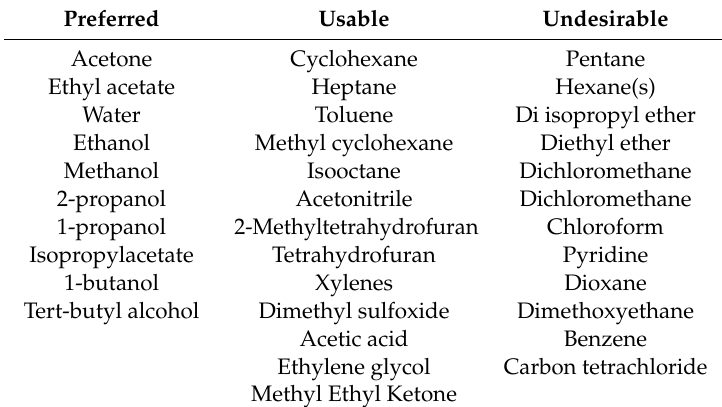
Table 3. Guide for solvent selection for synthesizing as well as facilitating the dissolution of ionic liquids in oil phase